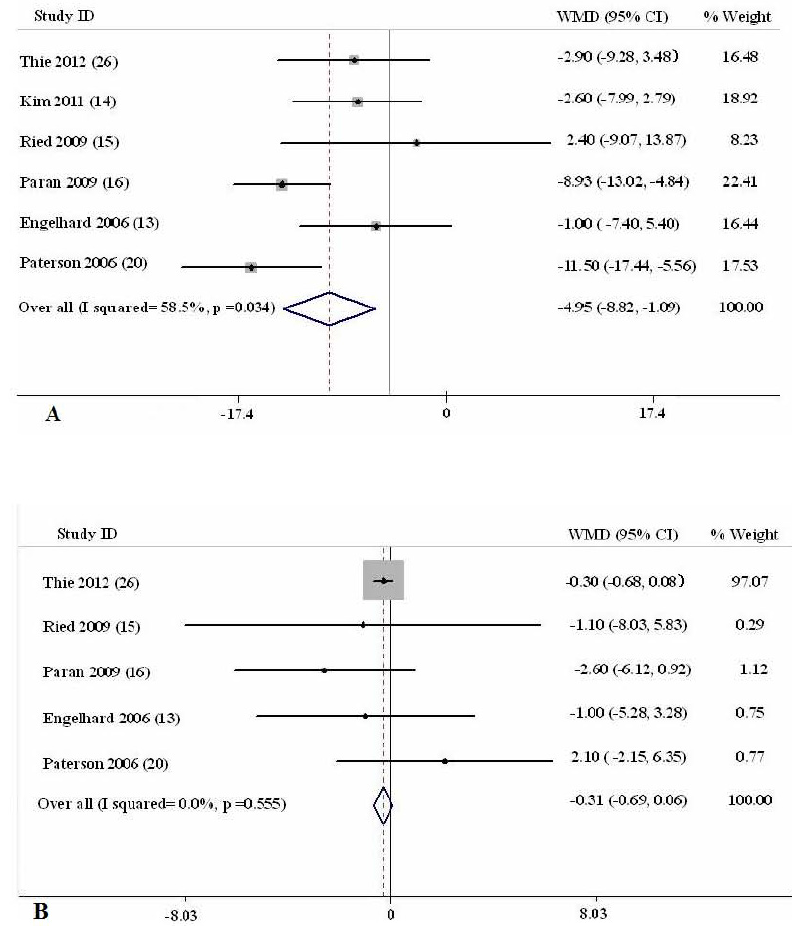
Figure 2. Meta-analysis of the effect of lycopene on blood pressure in the random effect model. WMD, weighted mean difference. ( A ): Systolic blood pressure; ( B ): Diastolic blood